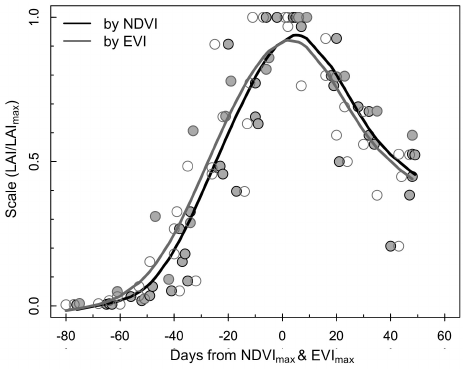
Figure 7. Consistent development curves drawn from the scaled LAI in relation to NDVI max and EVI max , respectively, using the generalized additive model. The data from all sites were used. Scale was calculated as the ratio of the observed LAI at each site to the average observed maximum LAI (LAI max , 5.3 from all sites).